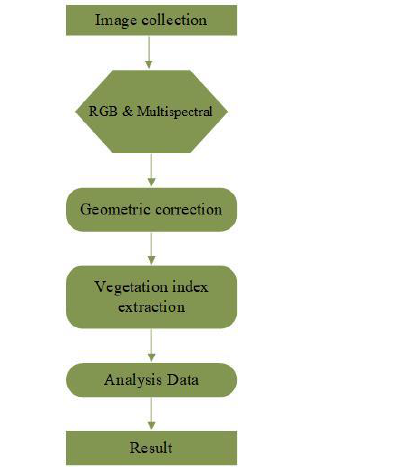
Figure 3. Procedure of the proposed